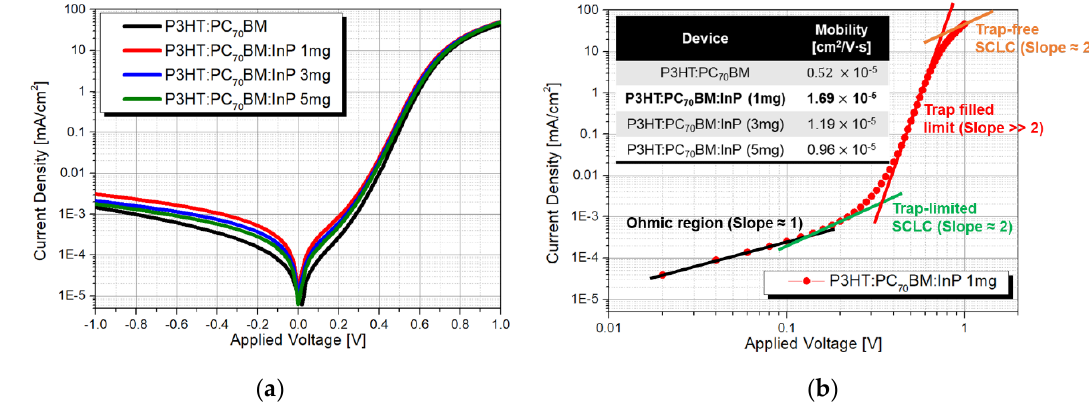
Figure 7. ( a ) J–V characteristics of detector with P3HT:PC 70 BM and P3HT:PC 70 BM:InP QDs (1, 3, 5 mg amount) under dark conditions and ( b ) the space charge limited current (SCLC) behavior of the detector with P3HT:PC 70 BM:InP QDs (1